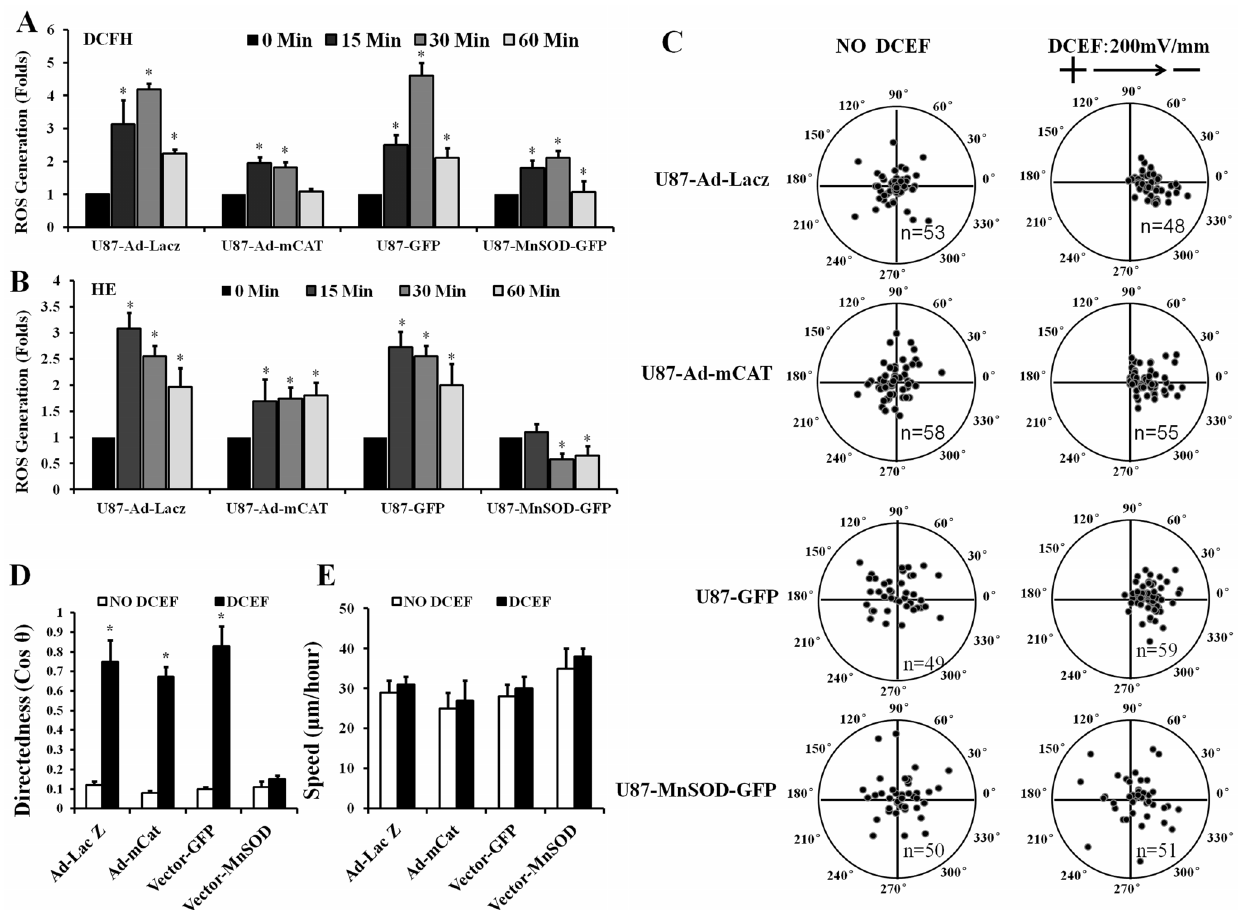
Figure 4. Overexpression of MnSOD, but not CAT, blocks DCEF-induced directional migration of U87 glioma cells. ROS generation in cells stimulated by an EF with a strength of 200 mV/mm 0, 15, 30, and 60 minutes with or without overexpression of MnSOD or mCAT, as detected by DCFH-DA (A) or HE (B). DCEF-induced (200 mV/mm) directional migration of U87 glioma cells is not affected by the overexpression of CAT, but is almost completely abolished by the overexpression of MnSOD (C). An analysis of direction (cos h ) and speed ( m m/h) of U87 glioma cell migration (D and E). Data are expressed as the mean 6 standard deviation (SD) (n=3). *Compared to cells not receiving EF treatment, P , 0.05.